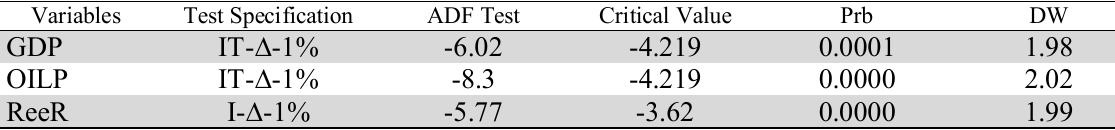
The results of ADF Test Variables Test Specification ADF Test